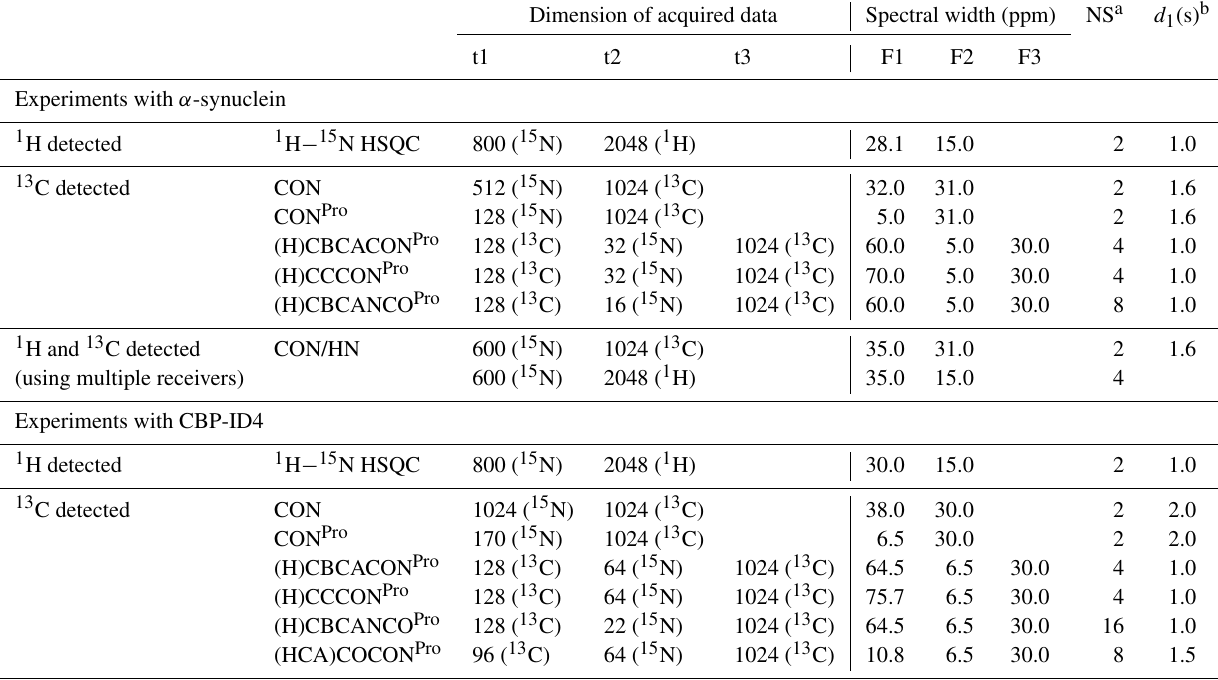
Dimension of acquired